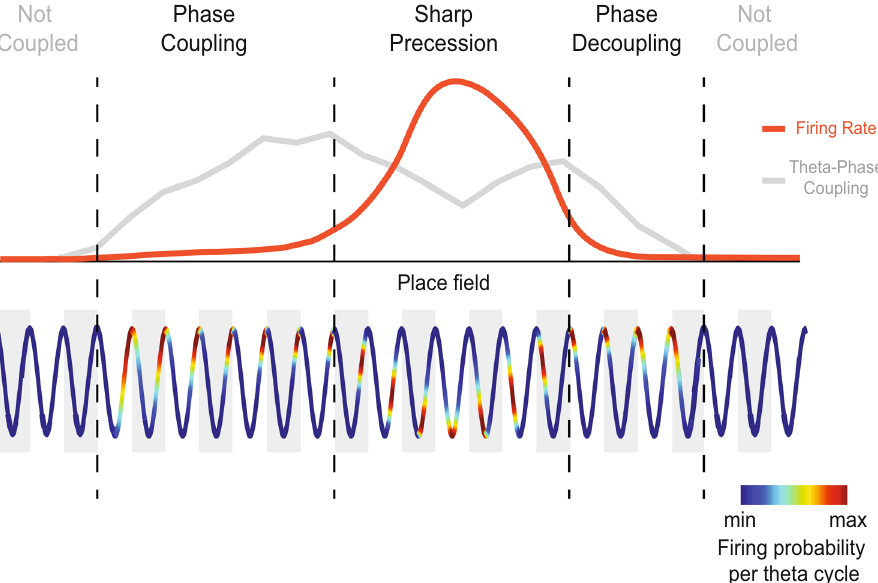
Figure 6. Schematic illustration of the three-stage spatial dynamics of place cell firing. The illustration depicts the changes in firing rate and in theta-phase coupling strength as the animal crosses a place field (top), as well as a schematic theta rhythm showing the probability of place cell firing within theta cycles along space (bottom). Our results suggest that the spatial dynamics of place cell activity occurs in three stages: “Phase Coupling”, when the probability of place cell firing progressively concentrates around a specific theta phase; “Sharp Precession”, when the concentrated spiking probability shifts to earlier phases of the theta cycle; and “Phase Decoupling”, when the spiking probability per theta cycle gradually returns to a uniform